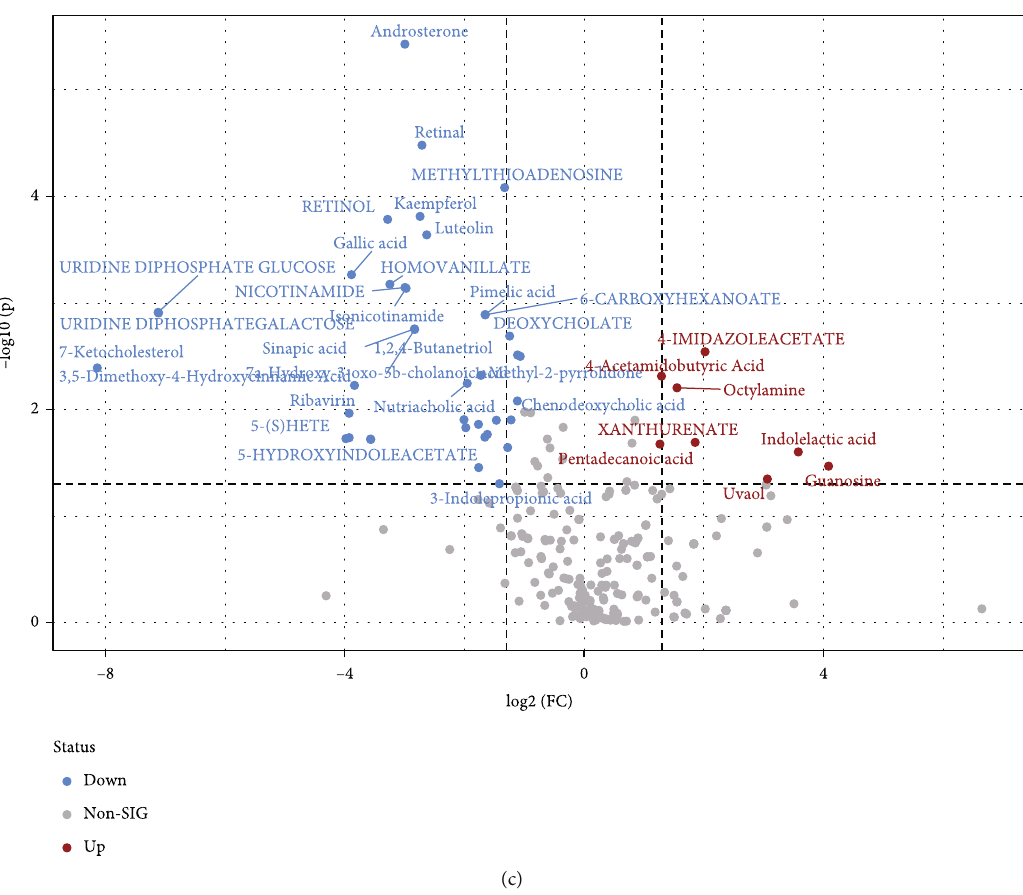
Figure 5: Metabolomics reveals the changes of intestinal metabolic phenotype in COPD patients. (a) PLSDA analysis. (b) Fold change. (c) Volcano